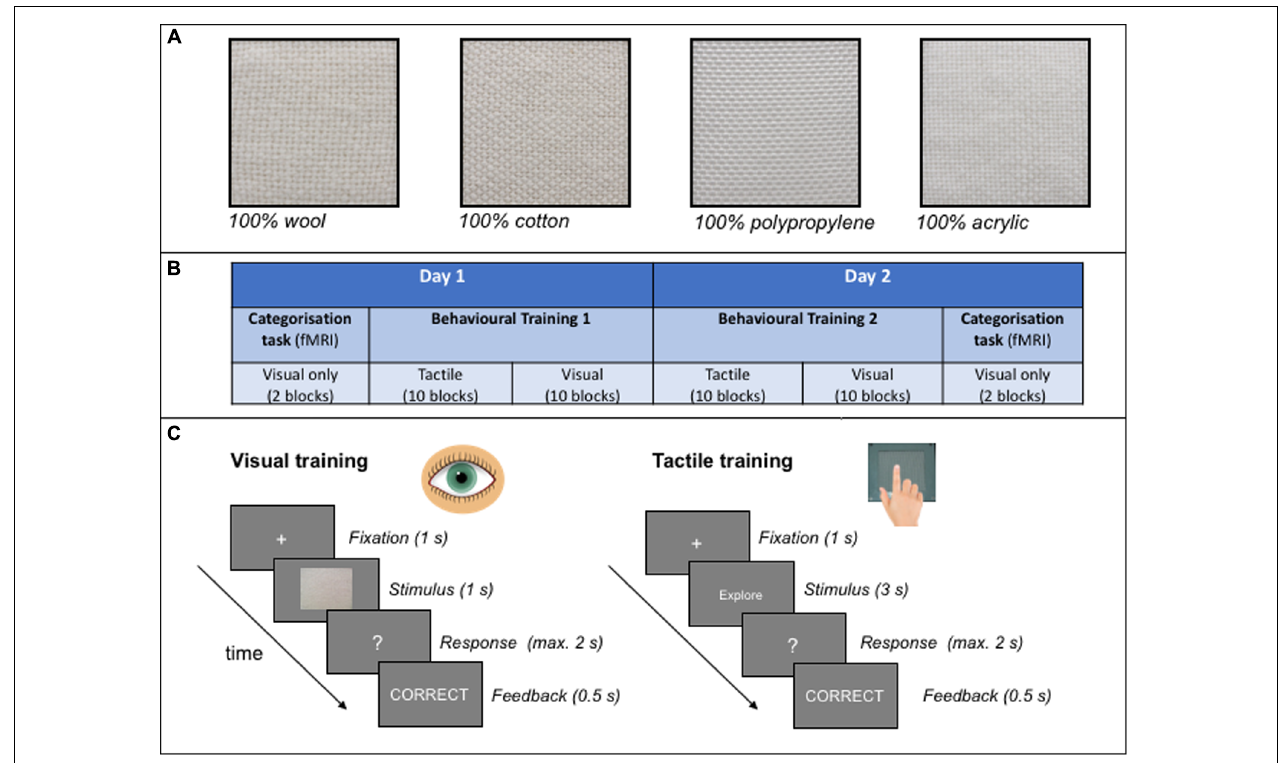
FIGURE 1 | (A) An example of some of the pure (100%) fabrics from either the natural (wool, cotton) or synthetic (polypropylene, acrylic) categories used as stimuli in the study. All samples shown are examples of coarse textures. (B) A schematic illustration of the experimental protocol adopted in the study. (C) An example of a typical trial structure in the visual and tactile behavioural training sessions. See text for further